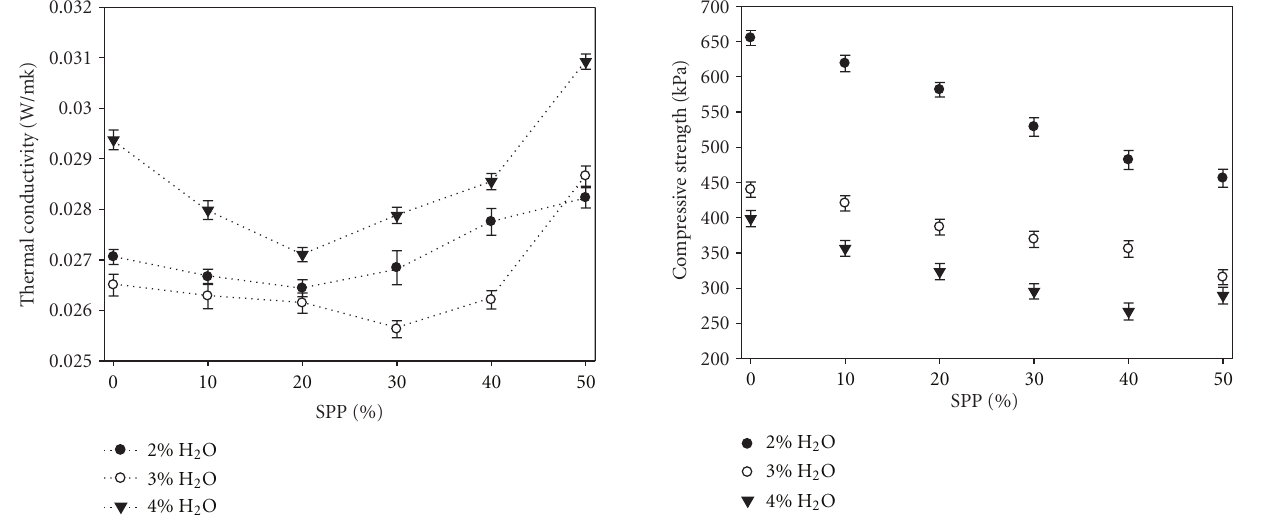
Figure 4: E ff ect of SPP percentage on thermal conductivity of rigid PU foams with di ff erent water contents.